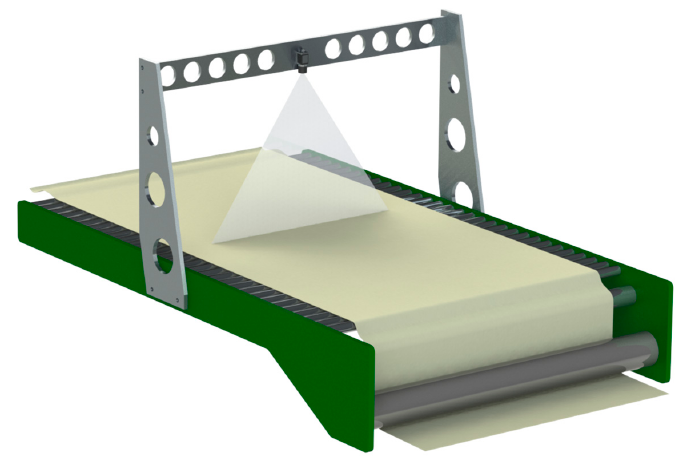
Figure 6. Architecture of the acquisition system. Due to confidentiality agreement, only a scheme of the system can be shown.